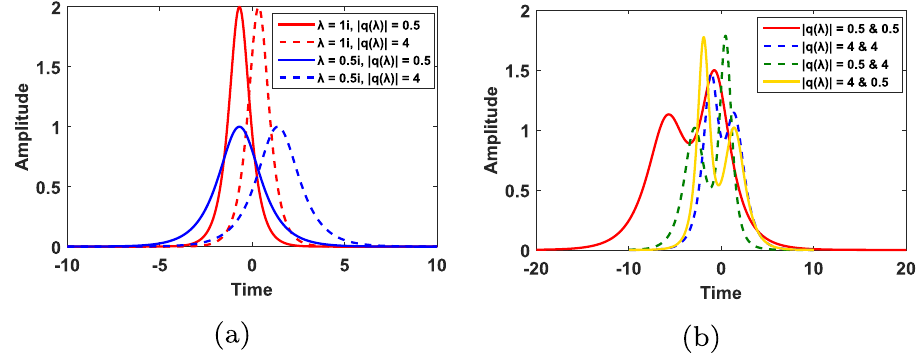
Figure 1. ( a ) Transmitted signals with only one eigenvalue produced by INFT. All the waveforms here are produced with one eigenvalue 1 i or 0.5 i , namely one soliton. In the one-soliton case there are totally 16 signals generated by two possible eigenvalues and 8 spectral functions (8QAM). Signals which only differ in spectral phases have the same envelope in time domain. So we have four different envelopes above. ( b ) Transmitted signals with both eigenvalues 1 i and 0.5 i produced by INFT. These signals share the same eigenvalues and differ in spectral functions.